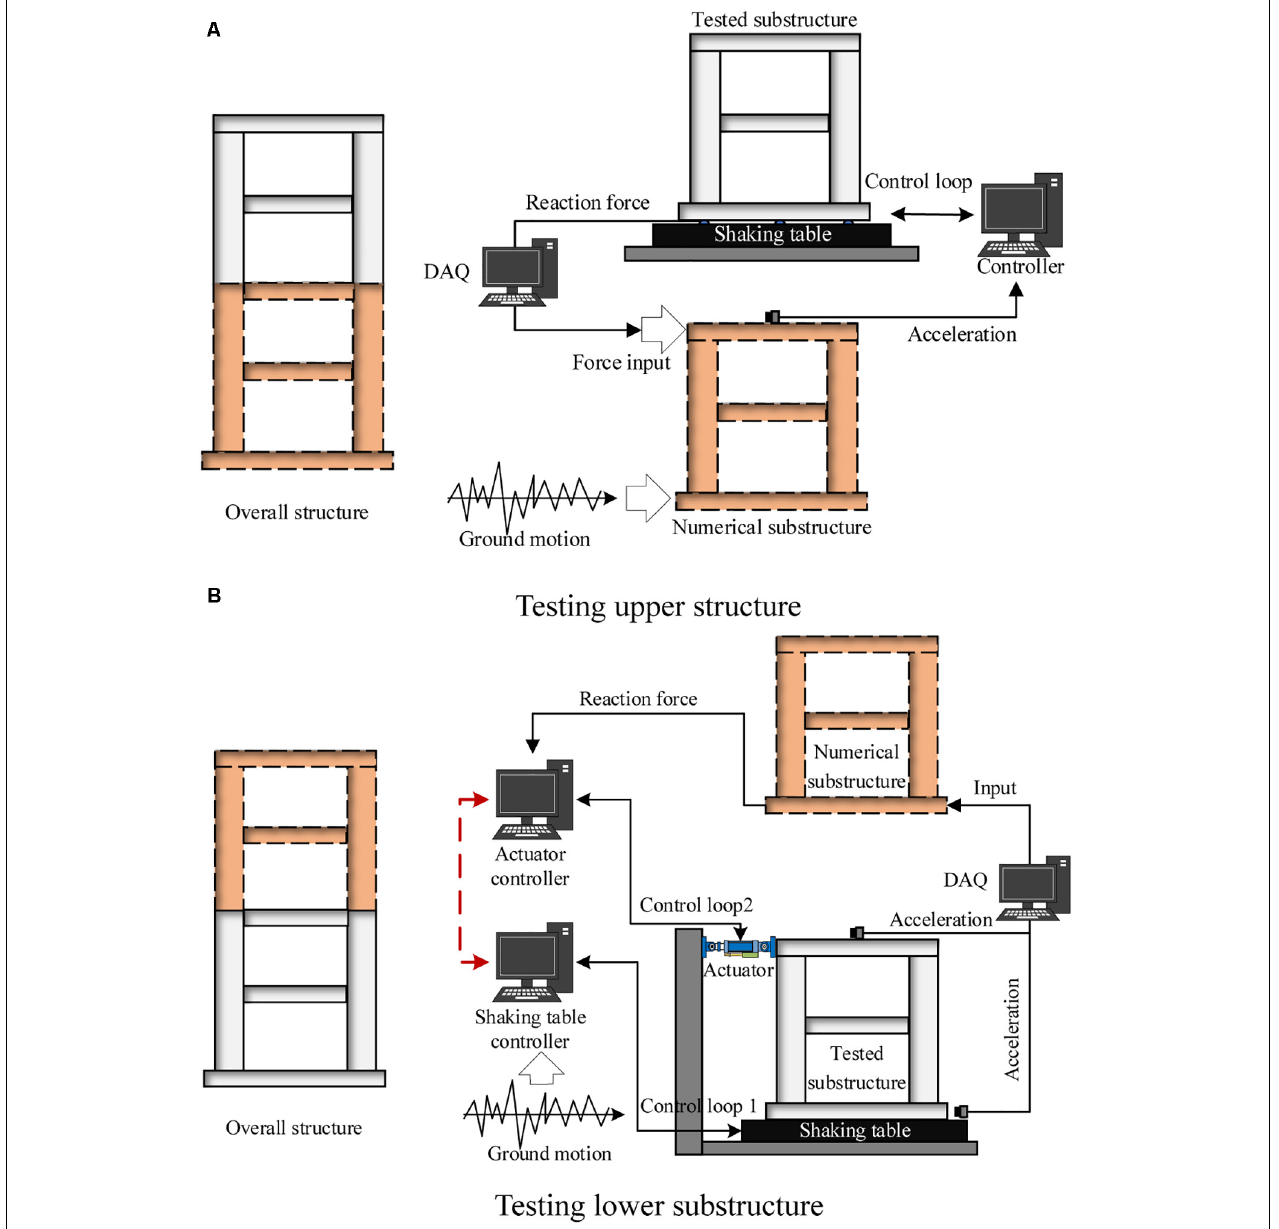
FIGURE 2 | Substructure patterns in STST. (A) Testing upper structure. (B) Testing lower